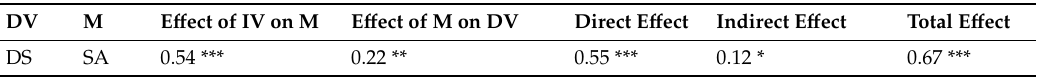
independent variable